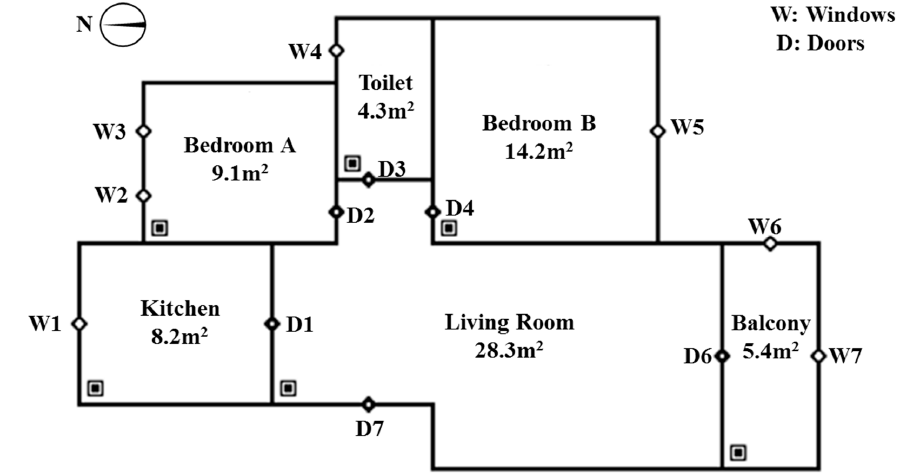
Figure 1. Building model created in CONTAM.